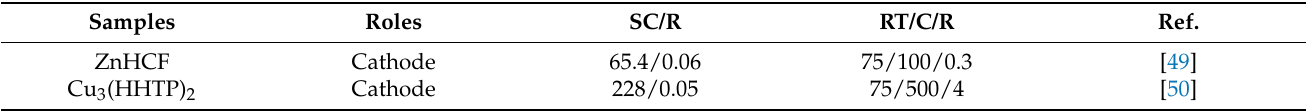
Table 1. List of the electrochemical performances of MOF-based materials in AZIBs. Samples